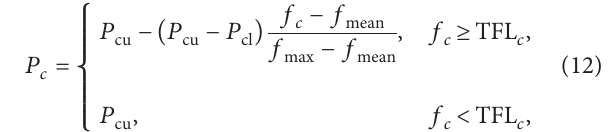
Figure 2: The frequency-domain spectrums of f as well as x ( t ) and f ( t